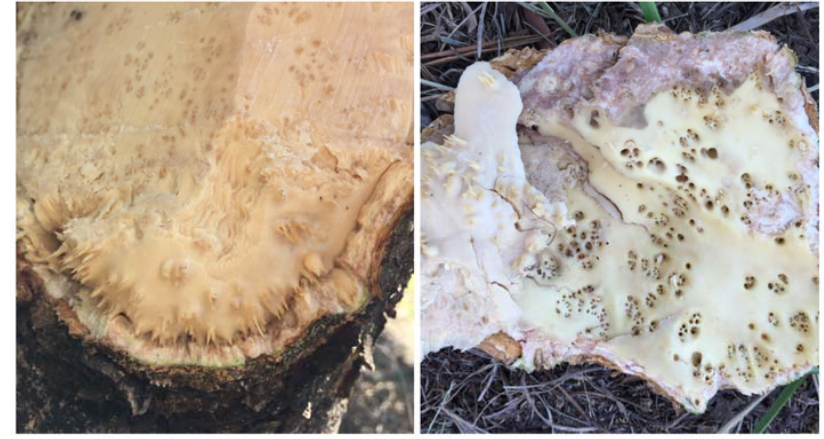
Figure 11. Wood deformations observed in the CS1 35 ‐ year ‐ old olive tree cv. Zarzaleña.